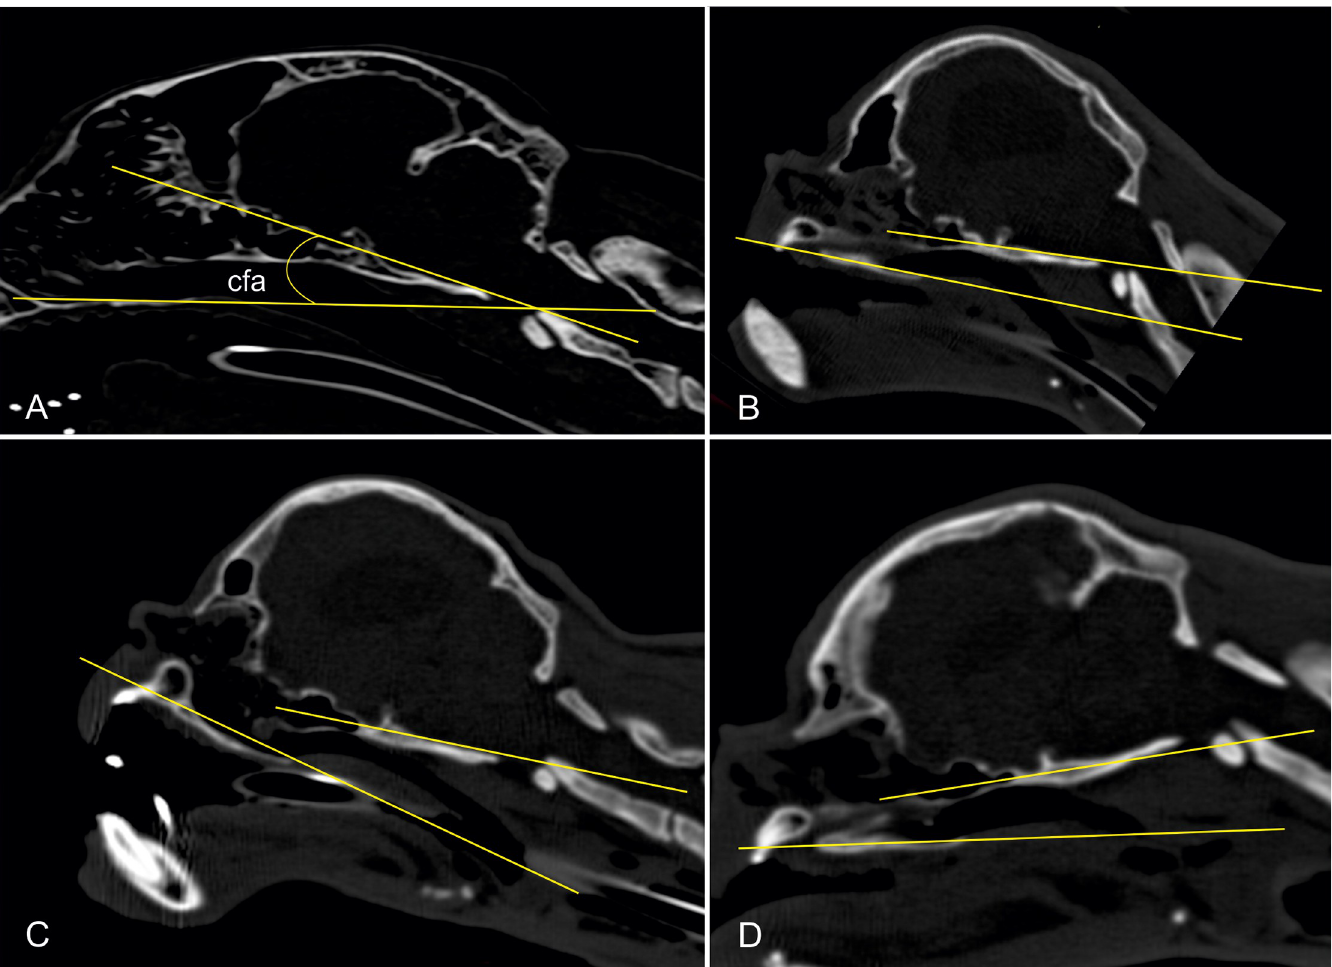
Fig 2. Measurement of the craniofacial angle. Two-dimensional CT images in a sagittal plane of a Domestic shorthair cat (A) and Persian cats with different cranial indices (B–D). The craniofacial angle is determined between the facial axis and the basilar axis. In Fig 2B–2D, the craniofacial angle (cfa) cannot be measured because the two axes